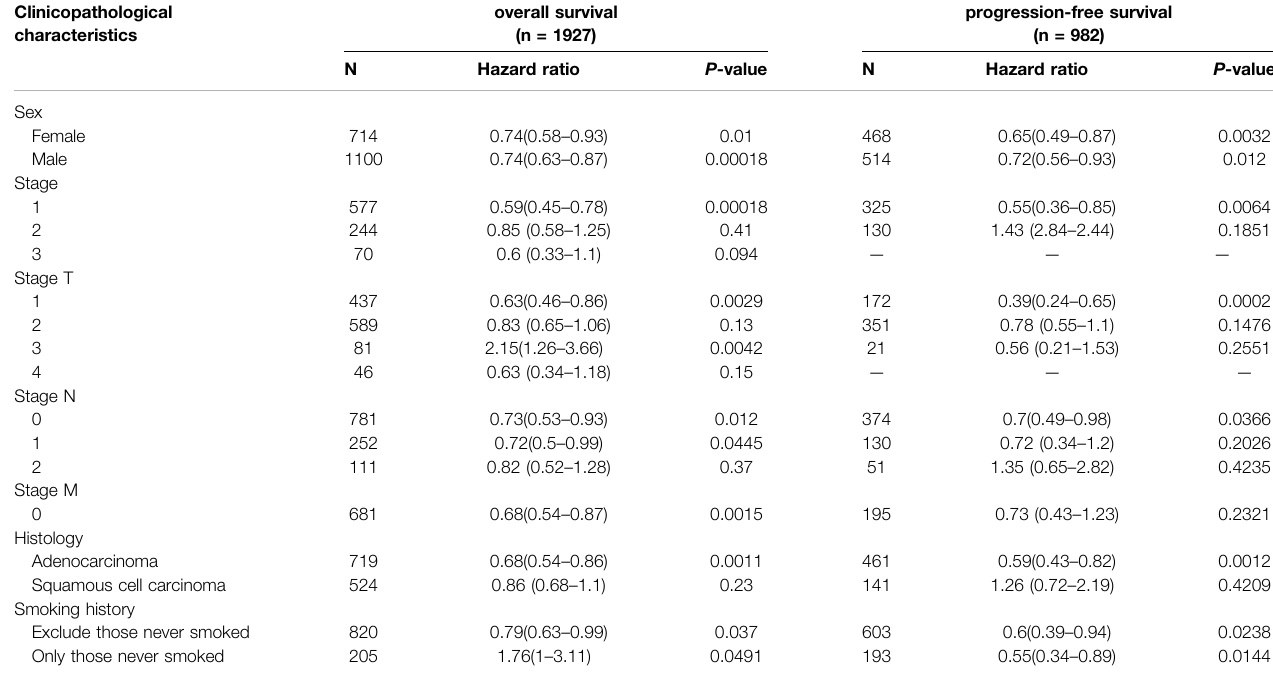
TABLE 1 | Correlation between CCL17 expression level and prognosis in lung cancer with different clinicopathological features by Kaplan – Meier plotter. Clinicopathological